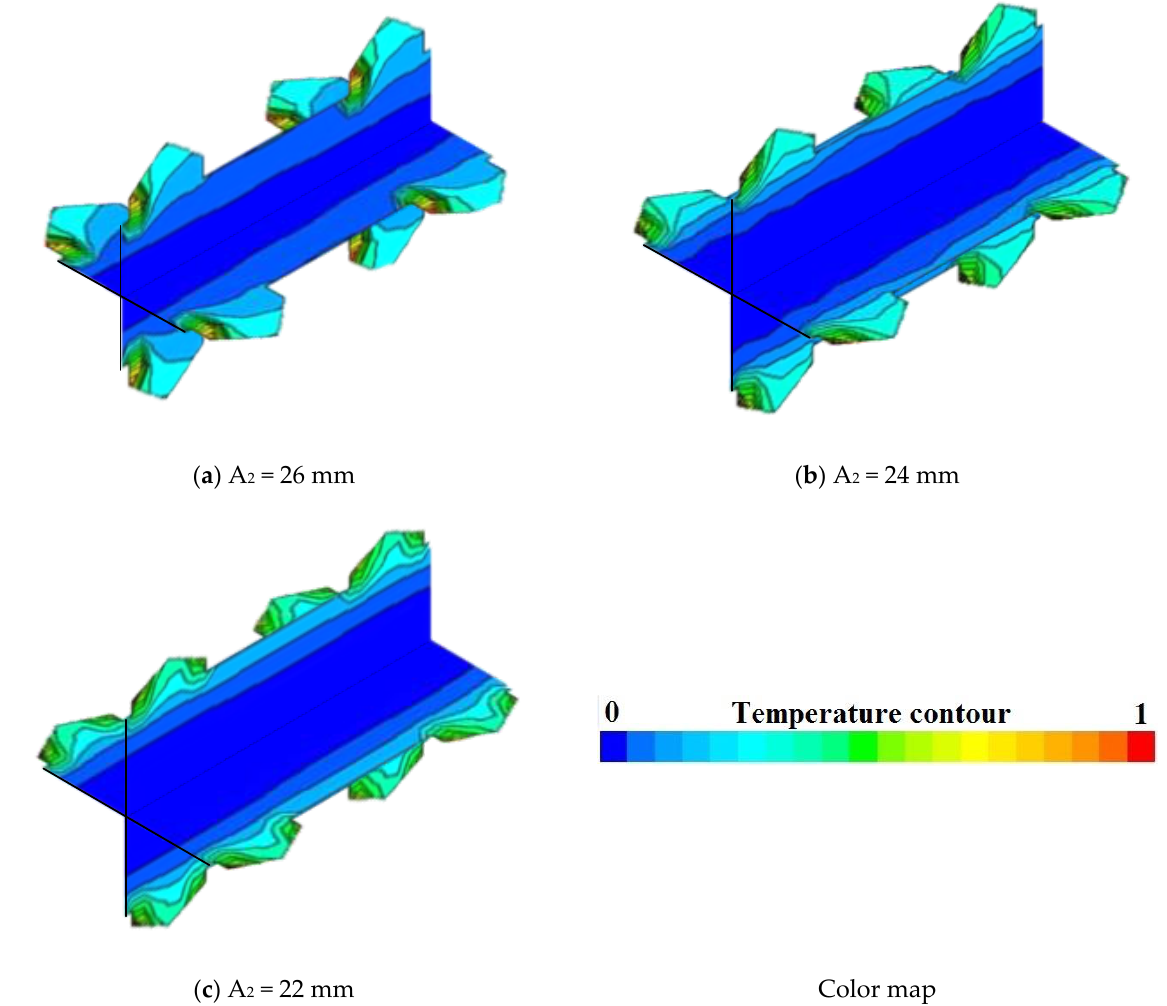
Figure 9. Temperature contours for various configurations of Case A with different A 2 parameters at R = 15 mm, Re = 15,000, and 𝜑 = 0.5%.